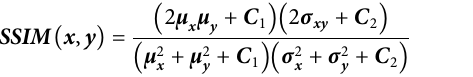
Frontiers in Bioengineering and Biotechnology |